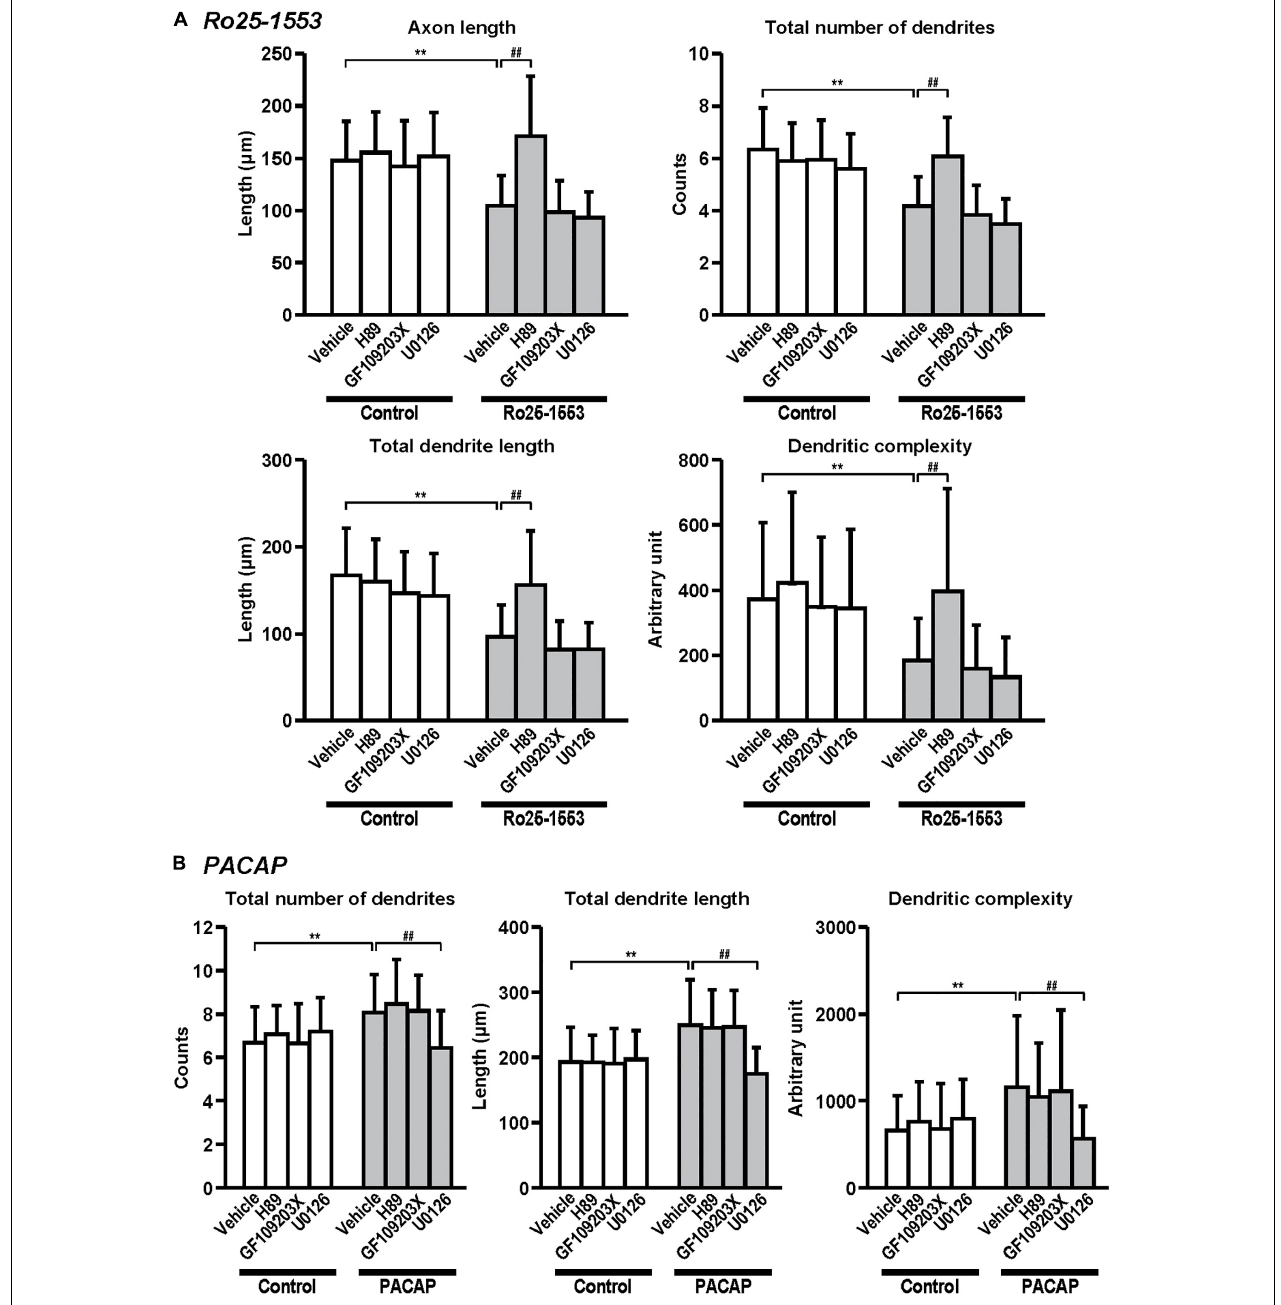
FIGURE 6 | Differential signaling pathways in the effects of Ro25-1553 and PACAP on axon and dendritic outgrowth. Primary cortical neurons were cultured with Ro25-1553 (10 nM) for 3 days in vitro (DIV) (A) or PACAP (100 nM) for 7 DIV (B) and double-immunostained for pNF and MAP2. H89 (1 µ M), GF109203X (1 µ M), or U0126 (1 µ M) was treated 30 min before the treatment with Ro25-1553 or PACAP. H89, but not GF109203X or U0126, blocked Ro25-1553-induced reductions in axon length (main effects: F 1 , 312 = 55.022, P < 0.0001 for Ro25-1553, F 3 , 312 = 21.421, P < 0.0001 for inhibitors; interaction: F 3 , 312 = 14.153, P < 0.0001), total numbers (main effects: F 1 , 312 = 107.531, P < 0.0001 for Ro25-1553, F 3 , 312 = 17.086, P < 0.0001 for inhibitors; interaction: F 3 , 312 = 14.788, P < 0.0001) and length (main effects: F 1 , 312 = 93.817, P < 0.0001 for Ro25-1553, F 3 , 312 = 16.605, P < 0.0001 for inhibitors; interaction: F 3 , 312 = 9.139, P < 0.0001) of dendrites, and dendritic complexity (main effects: F 1 , 312 = 39.122, P < 0.0001 for Ro25-1553, F 3 , 312 = 10.089, P < 0.0001 for inhibitors; interaction: F 3 , 312 = 3.091, P < 0.05). On the other hand, U0126, but not H89 or GF109203X, blocked PACAP-induced increases in total numbers (main effects: F 1 , 352 = 23.759, P < 0.001 for PACAP, F 3 , 352 = 4.738, P < 0.01 for inhibitors; interaction: F 3 , 352 = 9.465, P < 0.0001) and length (main effects: F 1 , 352 = 41.061, P < 0.001 for PACAP, F 3 , 352 = 9.241, P < 0.0001 for inhibitors; interaction: F 3 , 352 = 12.141, P < 0.0001) of dendrites, and dendritic complexity (main effects: F 1 , 352 = 14.664, P < 0.001 for PACAP, F 3 , 352 = 2.967, P < 0.05 for inhibitors; interaction: F 3 , 352 = 6.756, P < 0.001). Values represent mean ± SD of 40–45 neurons from three independent experiments. ** P < 0.01 vs. control, ## P < 0.01 vs. vehicle.